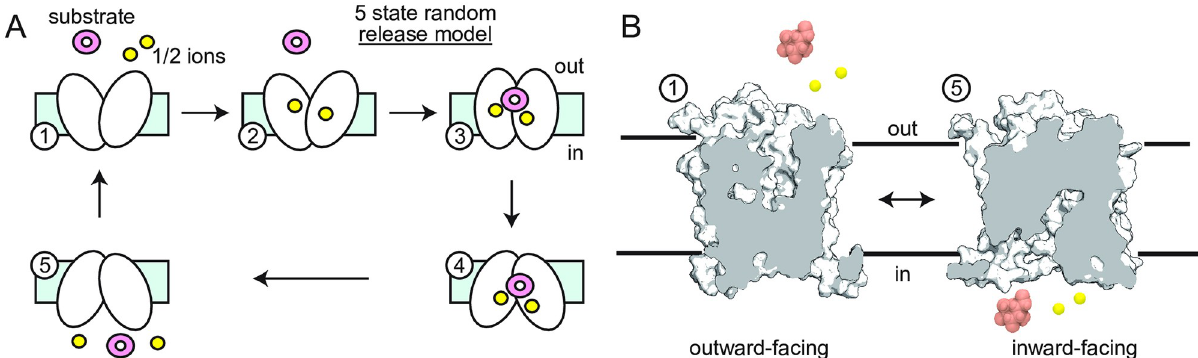
Fig 2. Kinetic models of sugar transport by SGLT symporters. A) Standard 5 state model of sodium-coupled transport based on Refs. [8, 17]. The protein cycles through outward empty (1), Na + -bound outward-open (2), substrate-bound occluded (3), substrate-bound inward-open (4), and inward- facing apo (5) states. Sugar (pink) and Na + (yellow) bind in an ordered manner from the extracellular side, but are randomly released to the cytoplasm. Two Na + are represented to indicate that some SGLTs bind 2 ions per cycle (hSGLT1), while others bind 1 (vSGLT and hSGLT2). B) Surface slice and cartoon view of vSGLT outward- and inward-facing states before substrate binding and after substrate release,